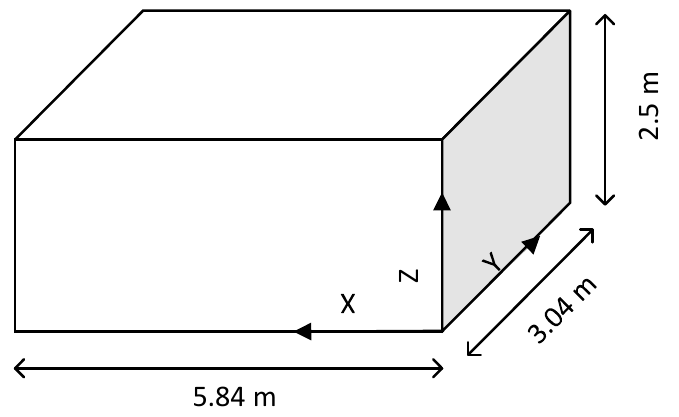
Figure 2. Experimental enclosure scheme of France’s CEA. The research parameter combinations are shown in Table